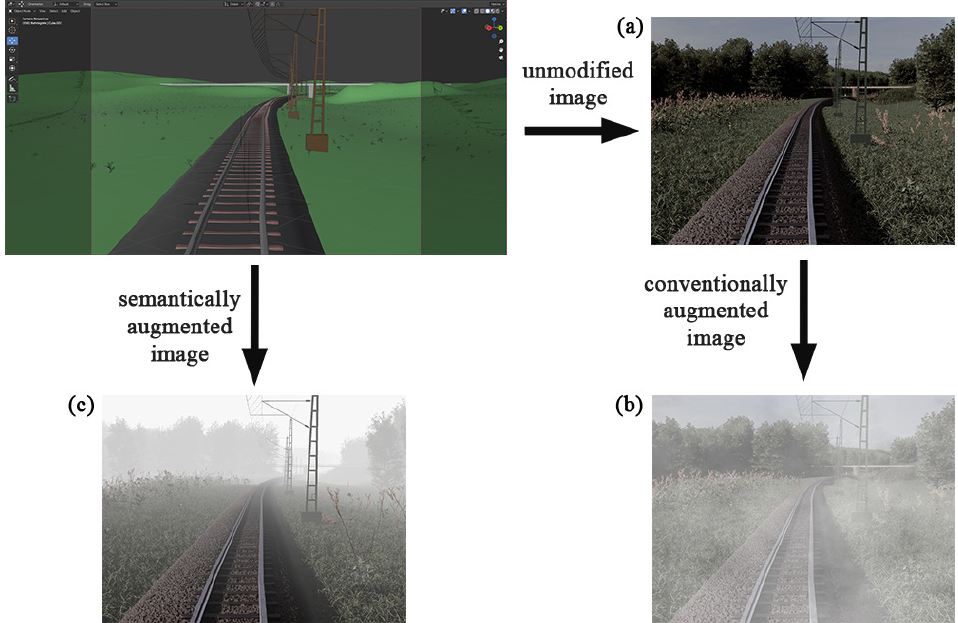
Figure 1. Comparison of original image ( a ), conventionally augmented image ( b ) and semantically augmented image ( c ); all created